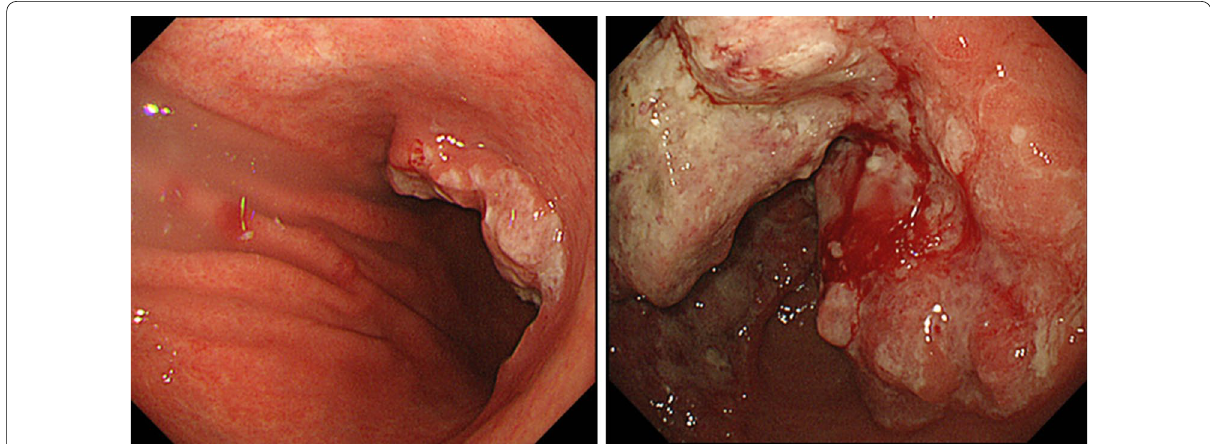
Fig. 1 Gastrointestinal endoscopy at the time of the initial examination revealed a Type 3 tumor, which mainly occupied the region from the lower gastric body to gastric antrum